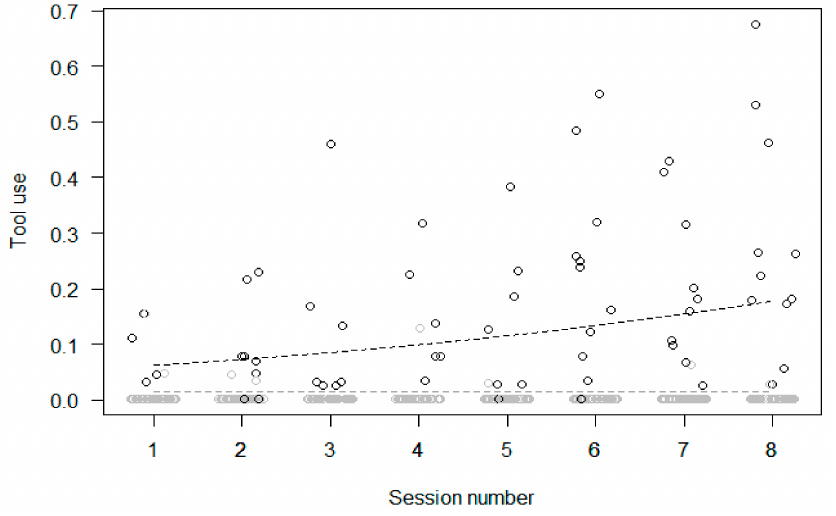
Figure 5. Tool use (i.e., proportion of scans where an individual engaged in tool use out of the total number of scans in which the subject was visible) as a function of time (i.e., enrichment session number) during the treatment phase. Circles represent individual responses in each enrichment session (i.e., in the morning and in the afternoon). Grey circles represent sessions in which the subjects did not participate in the enrichment task, and black circles those in which they participated. The dashed lines represent the fitted model, which is like Model 2b but unconditional on all the other predictors that were standardized. The black line represents the model for subjects participating in the enrichment task, and the grey line represents the model for those who did not participate in the task. Data were jittered horizontally to avoid overplotting.